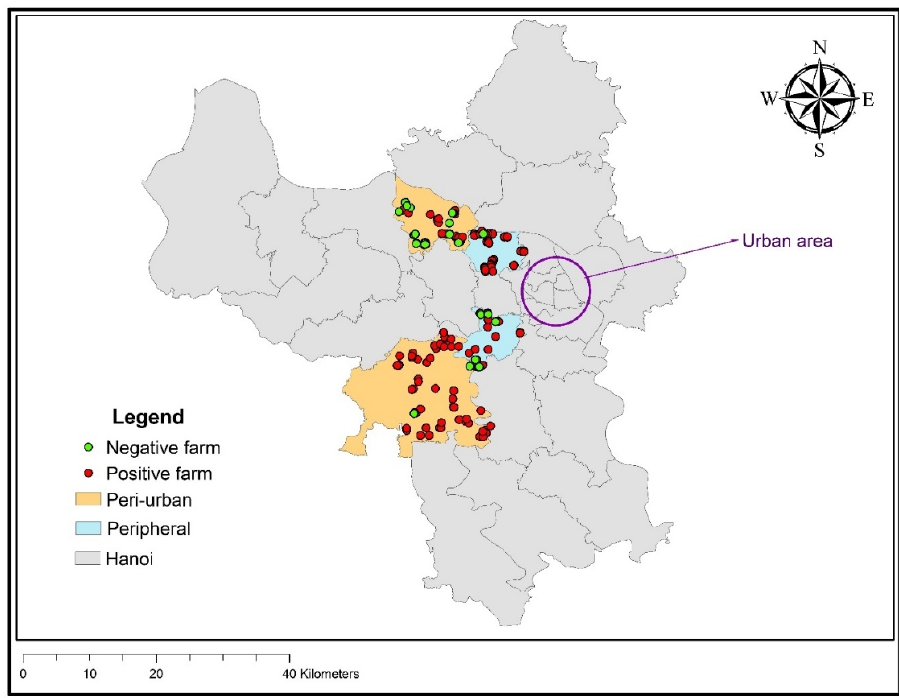
Figure 1. Distribution of sampled pig farms in Hanoi, Vietnam, and flavivirus serological results. Multi-stage sampling strategy was used as described earlier [16]. In brief, random selection of 20 global positioning system (GPS) points was made in every selected district, and about three pig-keeping households within a radius of 2 km from each GPS point were visited. The sample size calculation was described in our previous study describing differences between households with and without livestock, but was, in brief, based on a power of 0.8, a significance level of 0.05, and a desired detection of 20% difference between households with livestock keeping compared to households without livestock keeping